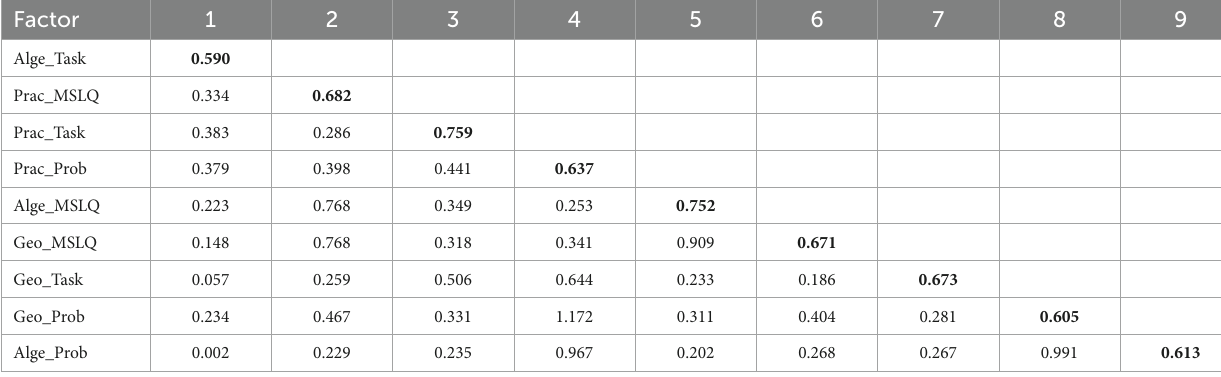
TABLE 5 Correlation indexes of first-order confirmatory factor analysis